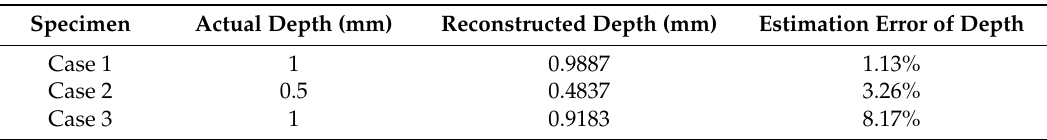
Figure 11. Simulation results of Case 1 to Case 3. ( a ) Wavenumber distribution of Case 1; ( b ) depth distribution of Case 1; ( c ) wavenumber distribution of Case 2; ( d ) depth distribution of Case 2; ( e ) wavenumber distribution of Case 3; ( f ) depth distribution of Case 3. The white circle represents the actual location of the damage. The actual defect depth of Case 1 and Case 3 is 1 mm, while the actual defect depth of Case 2 is 0.5 mm. Table 3. The depth evaluations of Case 1 to Case 3.